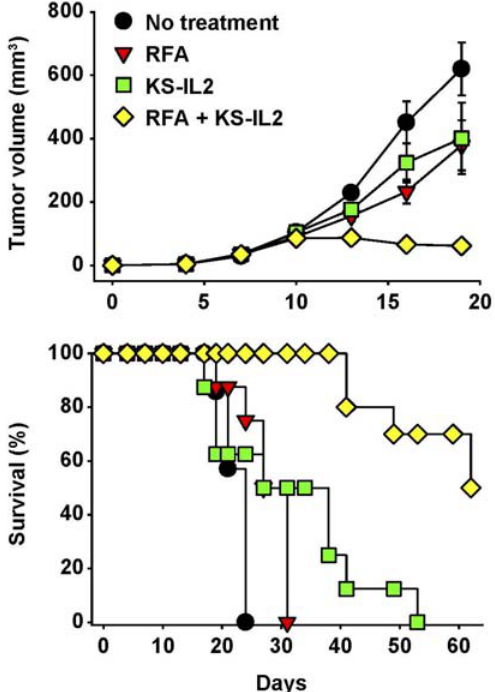
Figure 7. RFA and huKS-IL2 IC synergize in induction of antitumor effects. Balb/c mice (7–8 mice per group) received 5 × 10 5 CT26-KS cells s.c. in the abdomen on d0. Mice were treated with partial RFA (25 seconds, d11), KS-IL2 IC (15 μ g, d11-15), or both RFA and KS-IL2. Data shown are mean tumor volume ± SEM ( A ) or survival ( B ). The results are representative of 3 experiments. (Adapted from Johnson et al. , 2008,